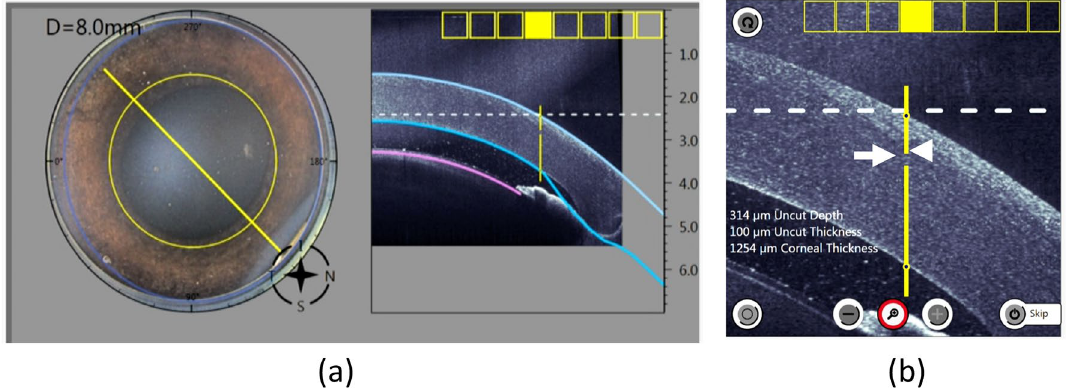
Figure 5. ASOCT scans were performed intraoperatively to mark the centration of the trephination and to adjust the thickness of the cut. Superior view showing the preselected diameter for the trephination ( a ). ASOCT shows the trephination line with the area where the uncut thickness and depth were ( b ; arrow and arrowhead, respectively).